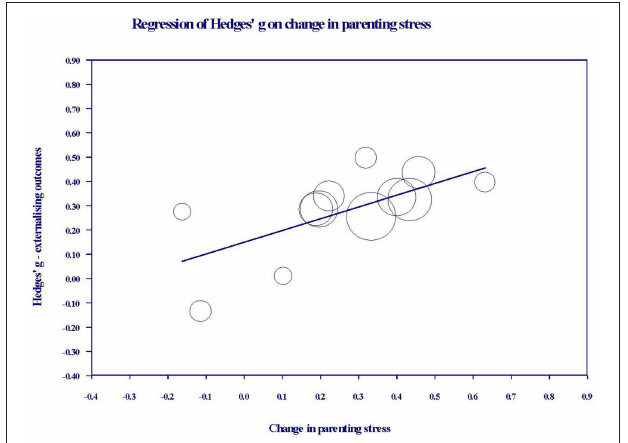
FIGURE 4 | Bubble plot of youth externalizing outcome effects against change in parenting stress. Each bubble represents a study, and the diameter of each bubble is proportional to the study weight.